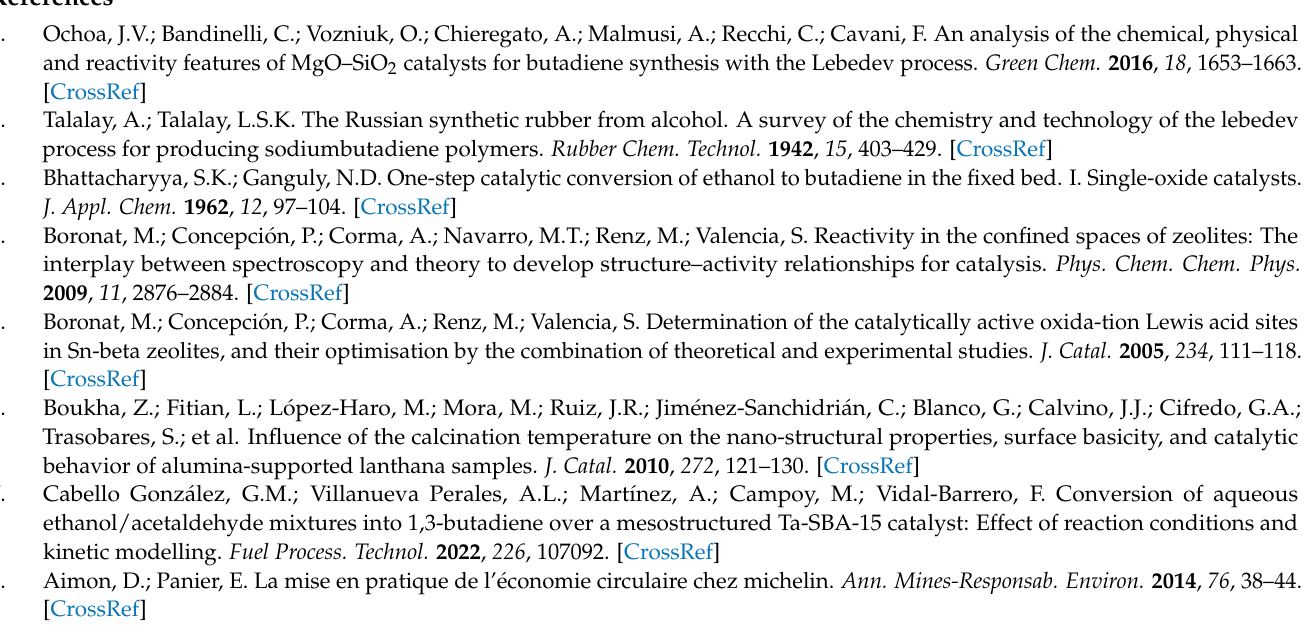
desorption curves. Figure S2 TGA curves of 50% CeO 2 -ZrO 2 and 30% TiO 2 -ZrO 2